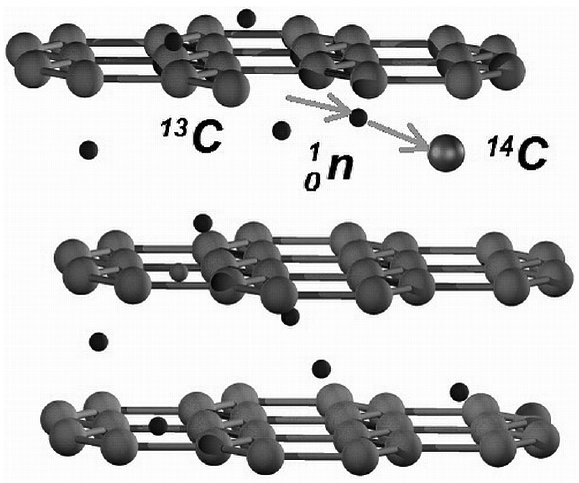
Figure 1. Layout of formation of 14 C positioned between graph- ite crystalline lattice